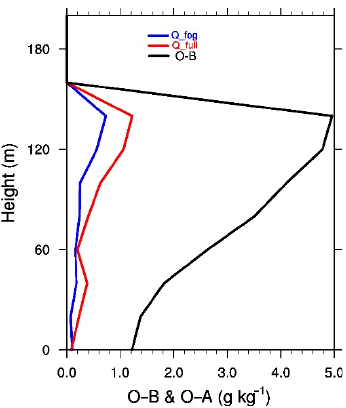
Figure 9. The vertical profiles of O–B (black) and O–A from the satellite-derived humidity DA cycle for the first DA cycle of Q_full (red) and Q_fog (blue) valid at 1900 UTC 28 April 2007 for specific humidity (g kg − 1 ). The O–A is the root-mean-square difference between the observed and the analyzed specific humidity and the O–B stands for the root-mean-square difference between the observed and the background specific humidity.